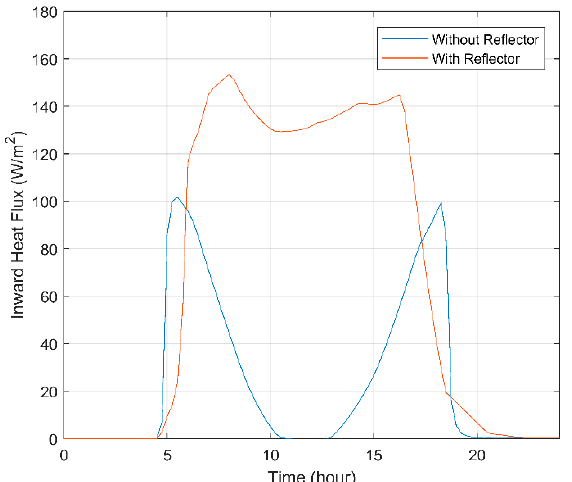
Figure 11. Variation in the amount of inward heat flux through the lower surface of the triangular SHC during a whole day with the effect of using the reflector.